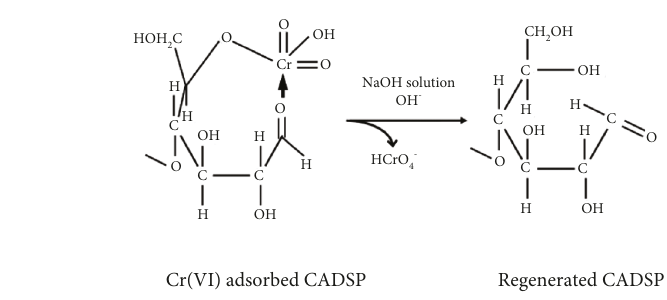
Scheme 3: Mechanism of desorption of